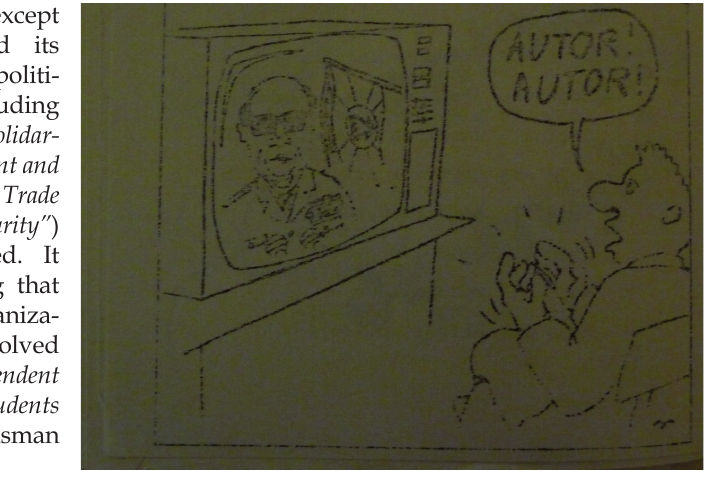
Fig. 1 AUTOR! AUTOR! Source: Satyra stanu wojennego